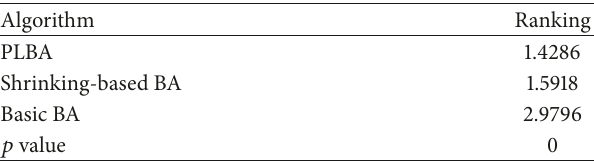
Table 13: Adjusted 𝑝 values associated with BA variants (Friedman) on dynamic benchmark problems 𝐹 1 – 𝐹 6 in terms of both solution quality and convergence speed.